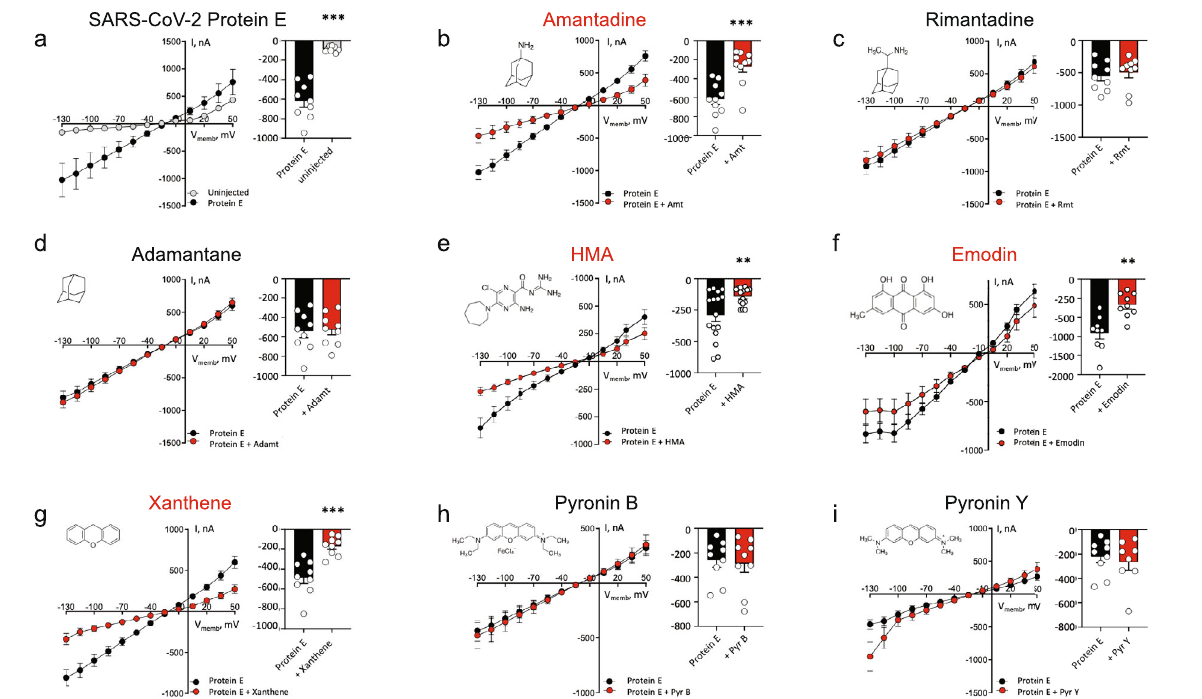
Fig. 1 Amantadine among other inhibitors blocks the ion channel function of SARS-CoV-2 Protein E. a Summarized and averaged I/V relations in SARS- CoV-2 Protein E-expressing oocytes revealed signi fi cantly different current activity compared to control (uninjected) oocytes. The current activity at − 85 mV in SARS-CoV-2 Protein E-expressing oocytes normalized to that of uninjected oocytes. b – i Eight compounds (10 μ M) were tested on SARS-CoV-2 Protein E activity. Amantadine ( b ), HMA ( e ), emodin ( f ), and xanthene ( g ) blocked the activity, whereas no inhibition of SARS-CoV-2 Protein E by rimantadine ( c ), adamantane ( d ), pyronin B ( h ), or pyronin Y ( i ) was observed. b – i current activity at − 85 mV with the treatment of the speci fi c drugs normalized to the current activity obtained without treatment. Statistical signi fi cance was determined with unpaired Student t test, ** P < 0.01; *** P < 0.001, of n = 4 biologically independent